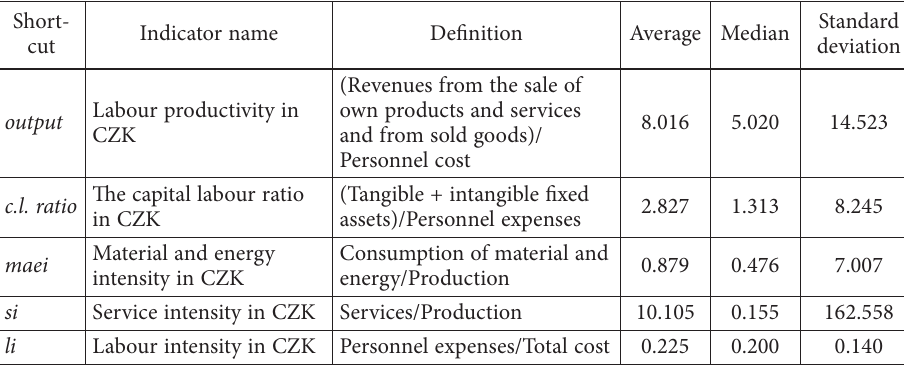
Table 1. Used indicators and summary statistics (source: authors’ calculation) Short- Indicator name cut